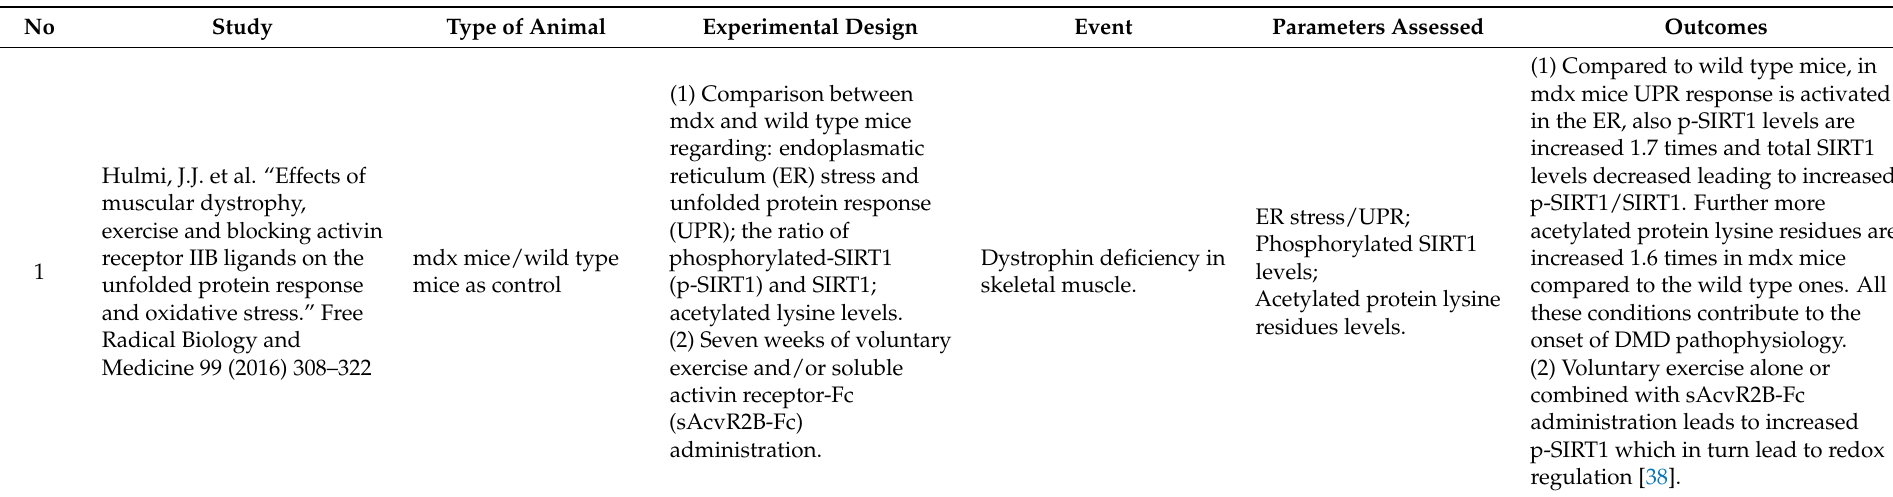
Table 1. Overview of the characteristics of in vivo animal studies included in the systematic